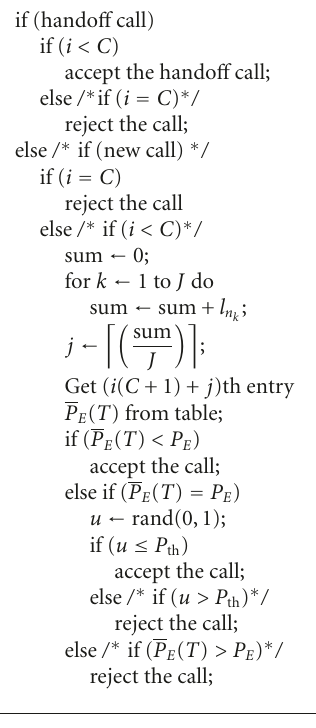
Pseudocode 2: Fractional adaptive